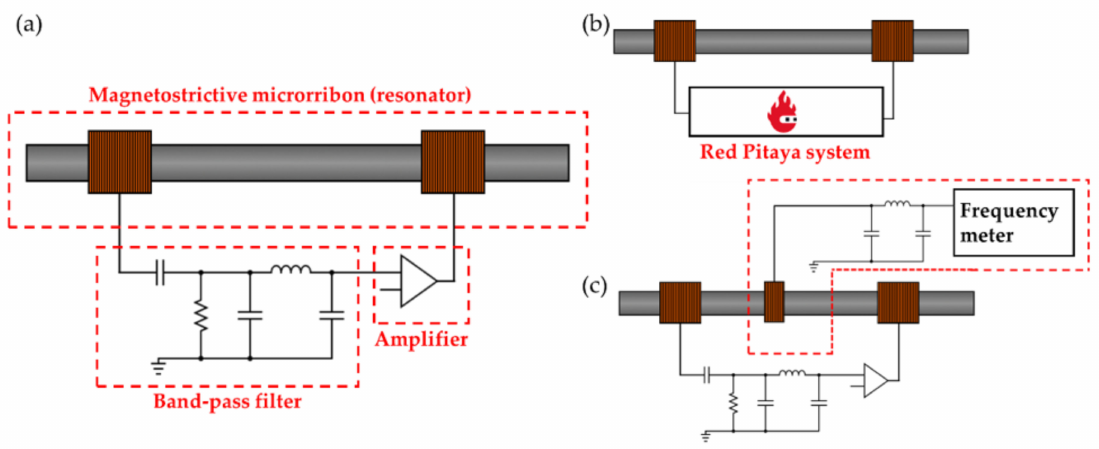
Figure 2. ( a ) Schematics of the oscillator circuit and electrical characterization setups for ( b ) frequency spectra and ( c ) real-time oscillator